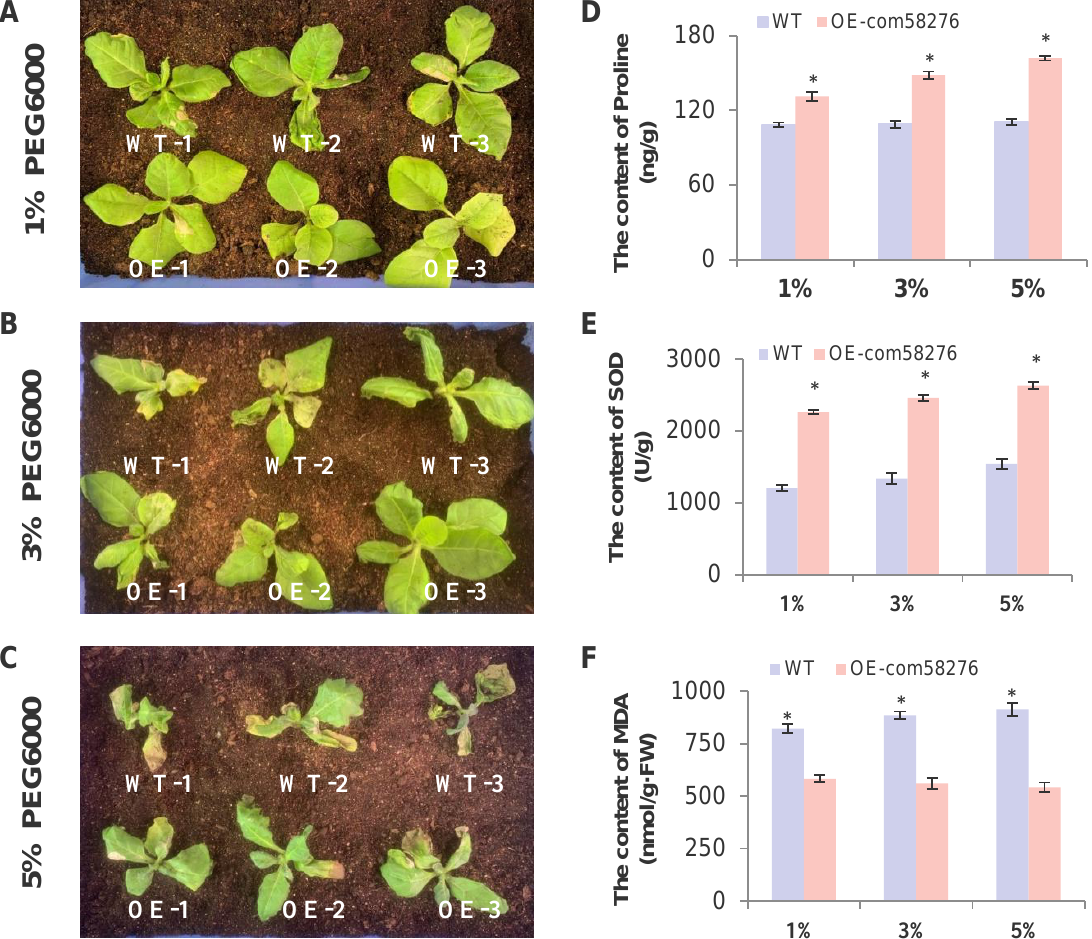
Figure 8. Drought treatment and physiological indicators of overexpressing com58276